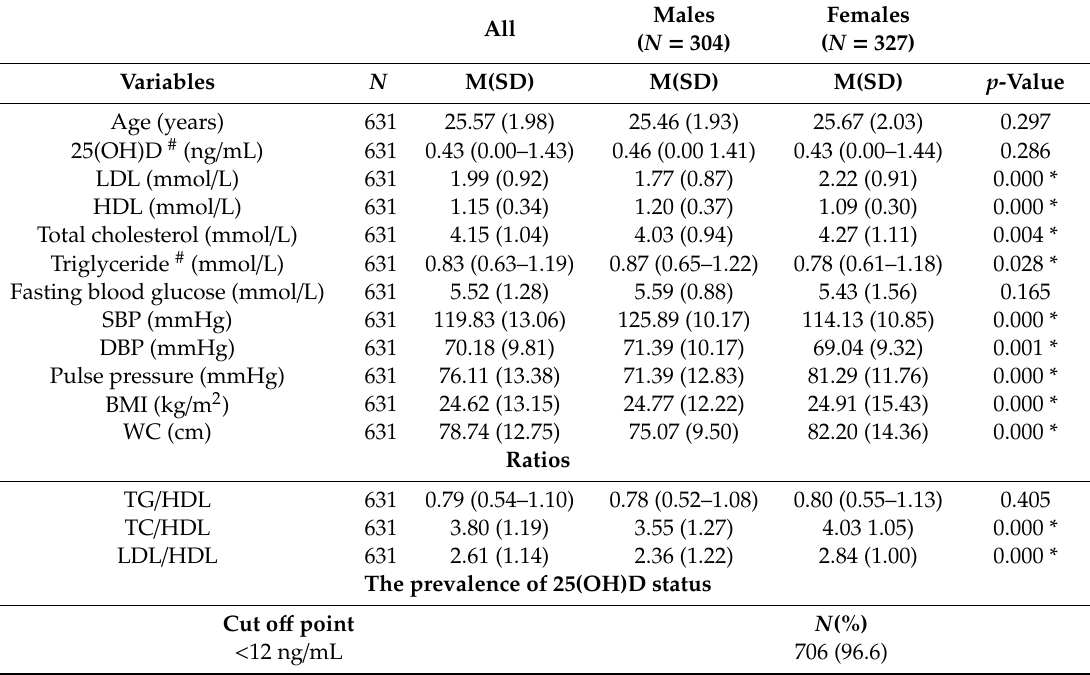
Table 1. Characteristics of the study sample by